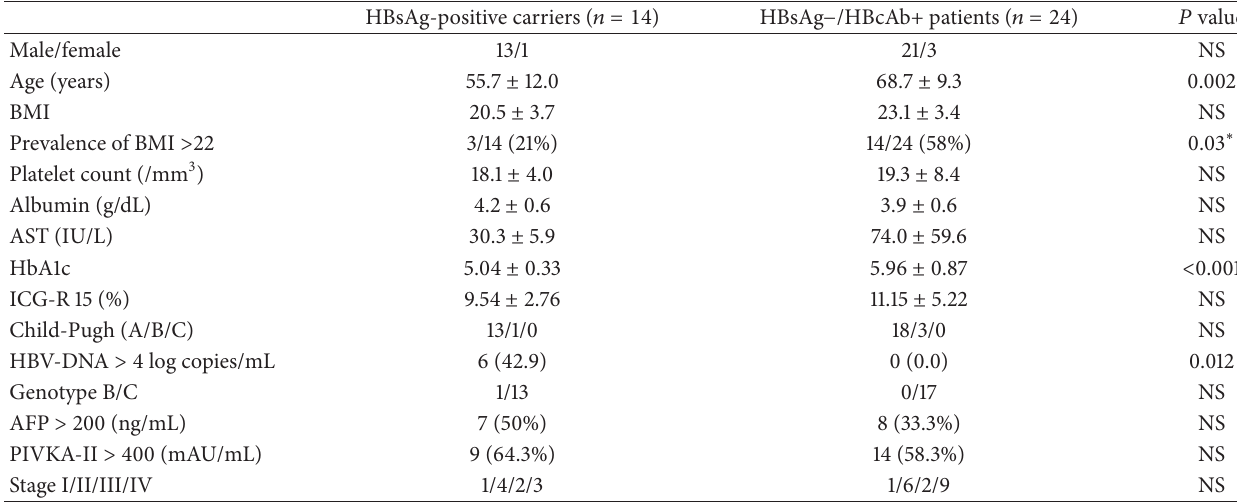
Table 2: Clinical characteristics of patients.